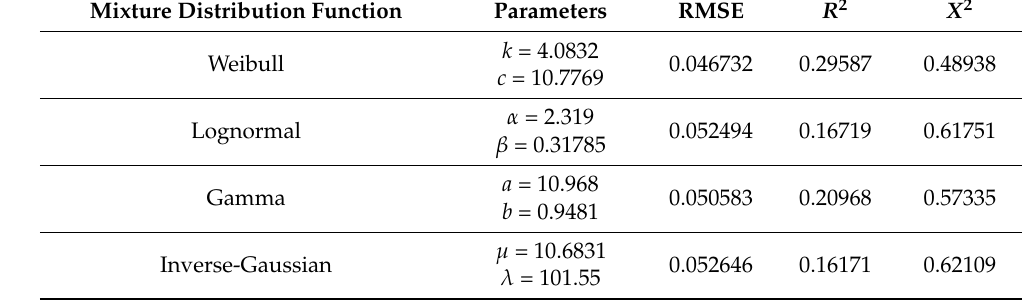
Table 4. Probability distribution parameters for the original PDFs in the solar irradiance modeling.